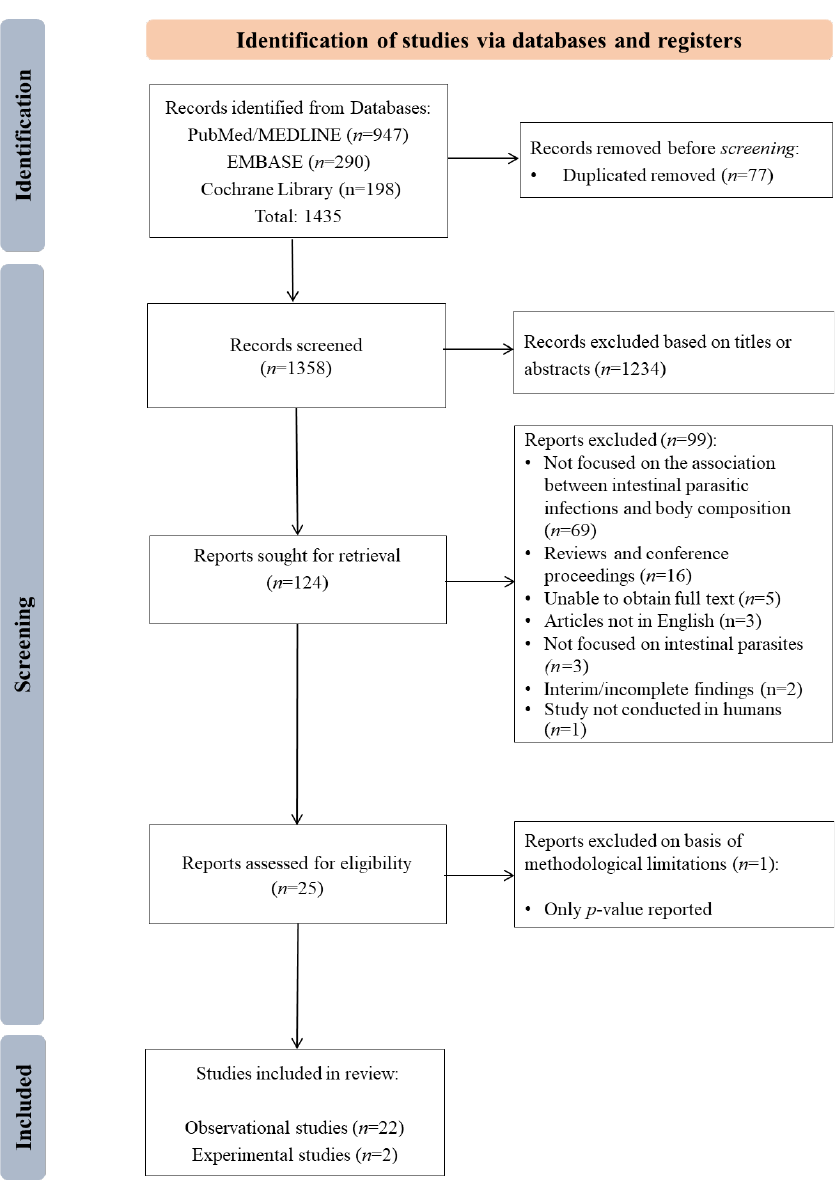
Figure 1. Flowchart of the search and selection of the studies for review.